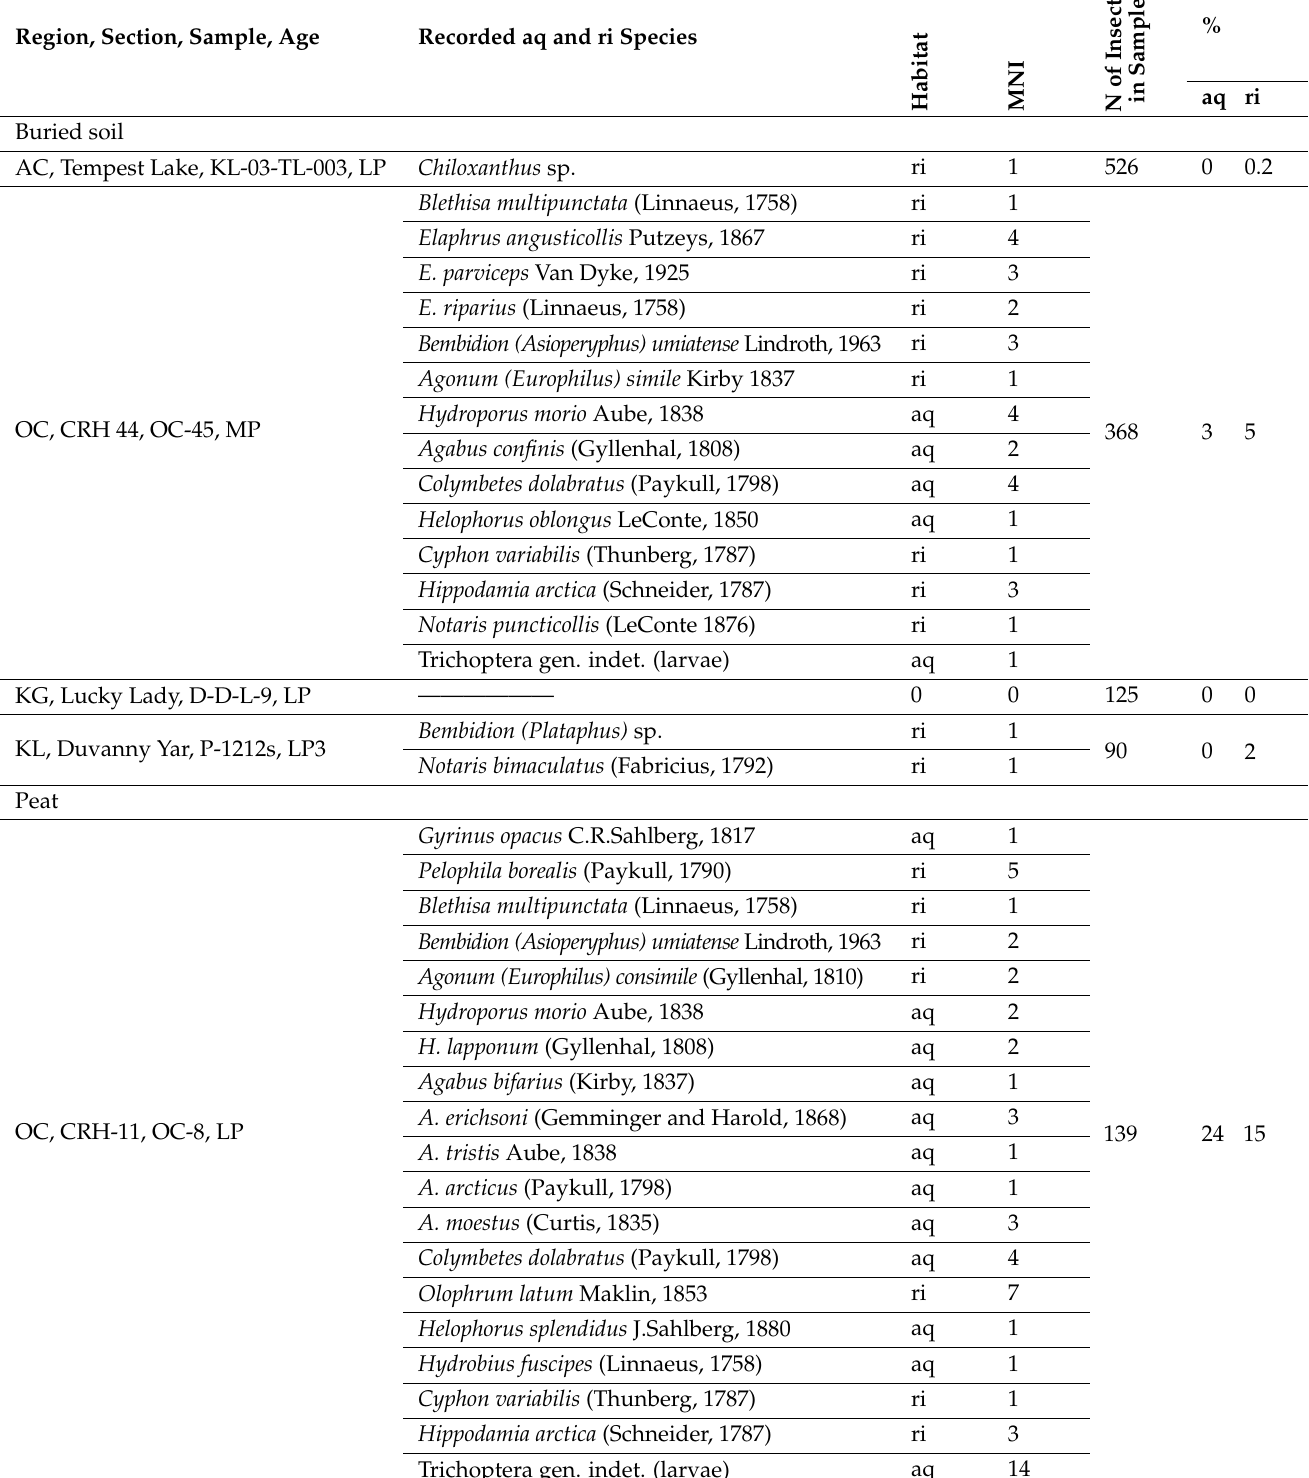
Table 4. Occurrence of water indicators and their percentage of assemblages in different sedimenta- tion